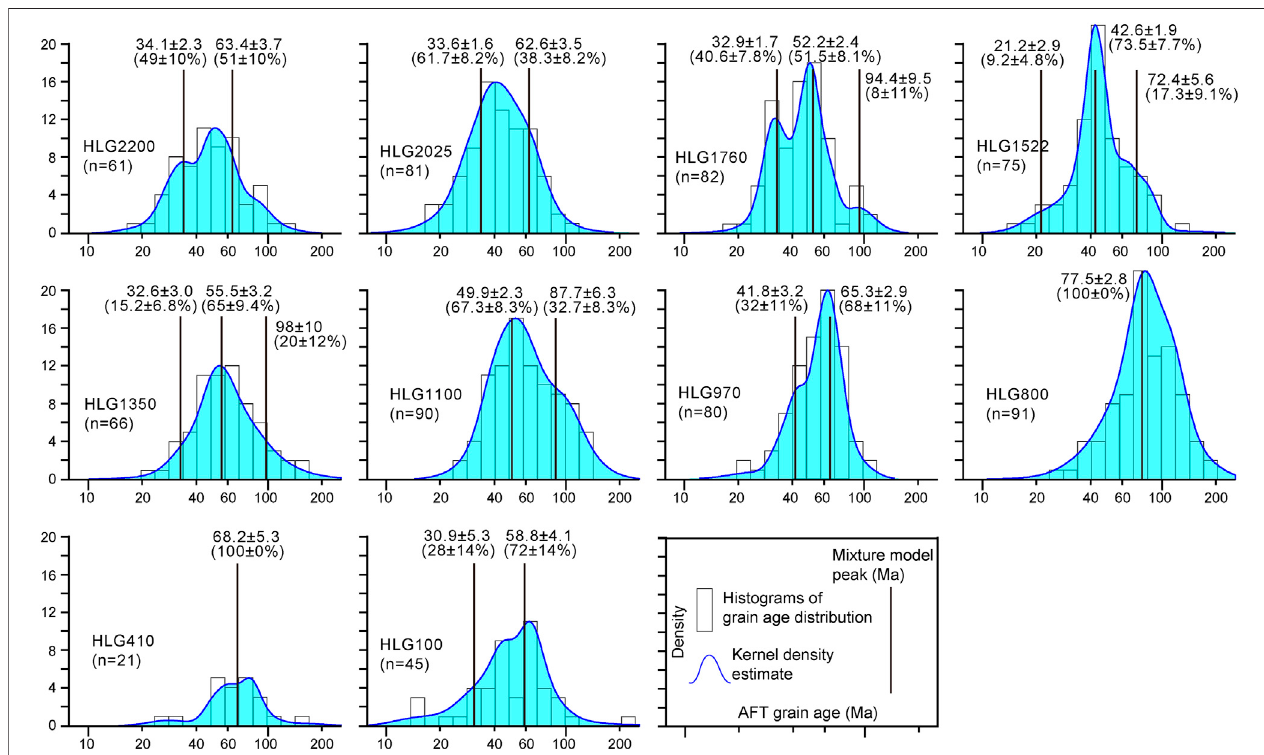
FIGURE 4 | Grain-age distributions, kernel density estimates, and mixture model peaks (with modelled component ages and proportions) of detrital AFT samples. Single-grain ages are statistically decomposed into components using the routines in DensityPlotter (Vermeesch, 2012).